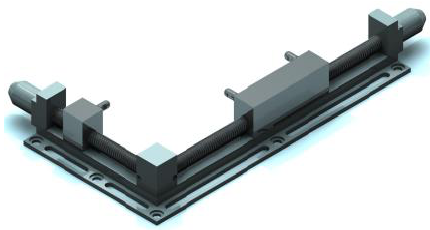
Figure 2. Adjustable locating module for locating of prismatic parts in “quadrantal